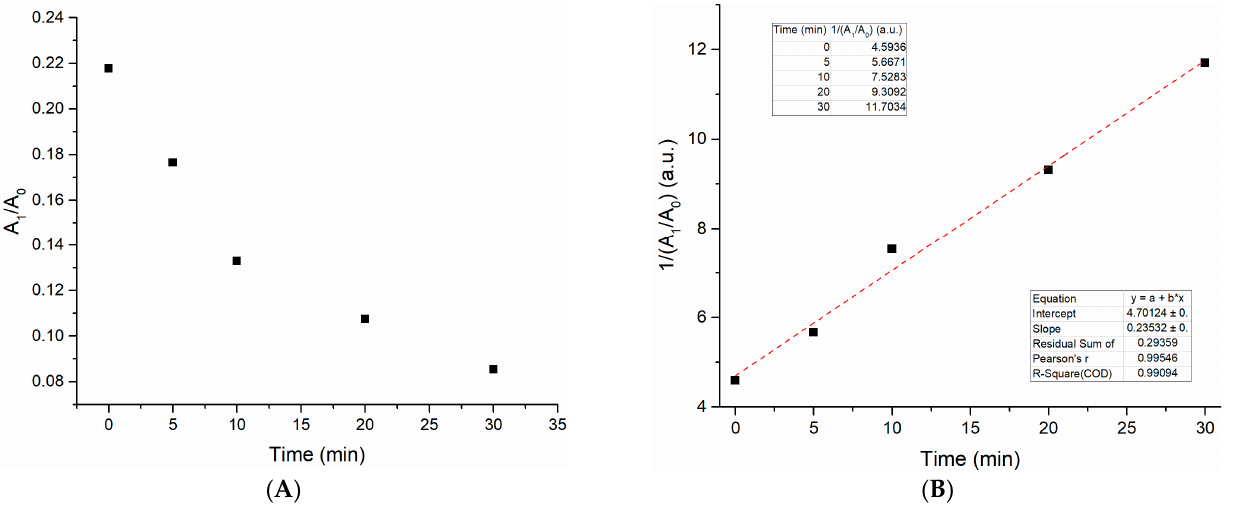
Figure 3. ( A ) Plot of the FT-IR peak area ratio (A 1 /A 0 ) as a function of plasma treatment time. ( B ) A second-order treatment of the A 1 /A 0 ratio was plotted by graphing the inverse of this ratio as a function of treatment time. The first inset is a table with the inverse ratio values at each treatment time. The second inset shows several relevant parameters for the linear fit and, most importantly, the R-squared value of